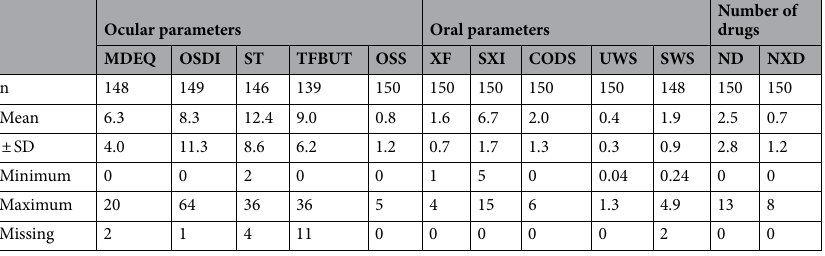
Table 2. Mean values, SD, minimum, maximum, and missing values for ocular, oral and drug parameters. MDEQ McMonnies Dry Eye Questionnaire, OSDI Ocular Surface Disease Index, ST Schirmer I Test (mm/5 min), TFBUT tear film break-up time, OSS ocular surface staining, XF xerostomia frequency, SXI summated xerostomia inventory, CODS clinical oral dryness score, UWS unstimulated whole saliva (mL/min), SWS stimulated whole saliva (mL/min), ND number of drugs, NXD number of xerogenic drugs.